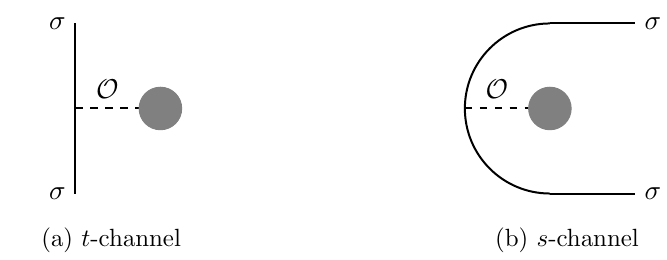
Figure 7. An illustration of how the inversion formula relates between s - and t -channels in the h (cid:27)(cid:27) i (cid:12) correlator. A single term in the t -channel OPE O 2 (cid:27) (cid:2) (cid:27) represented in (a), inverts to a part of the sum over the [ (cid:27)(cid:27) ] n families in the s -channel, which are represented in (b). Alternatively, the sum in (b) over a h (cid:27)(cid:27) i ; ( O ) reproduces the O term in [ (cid:27)(cid:27) ] n